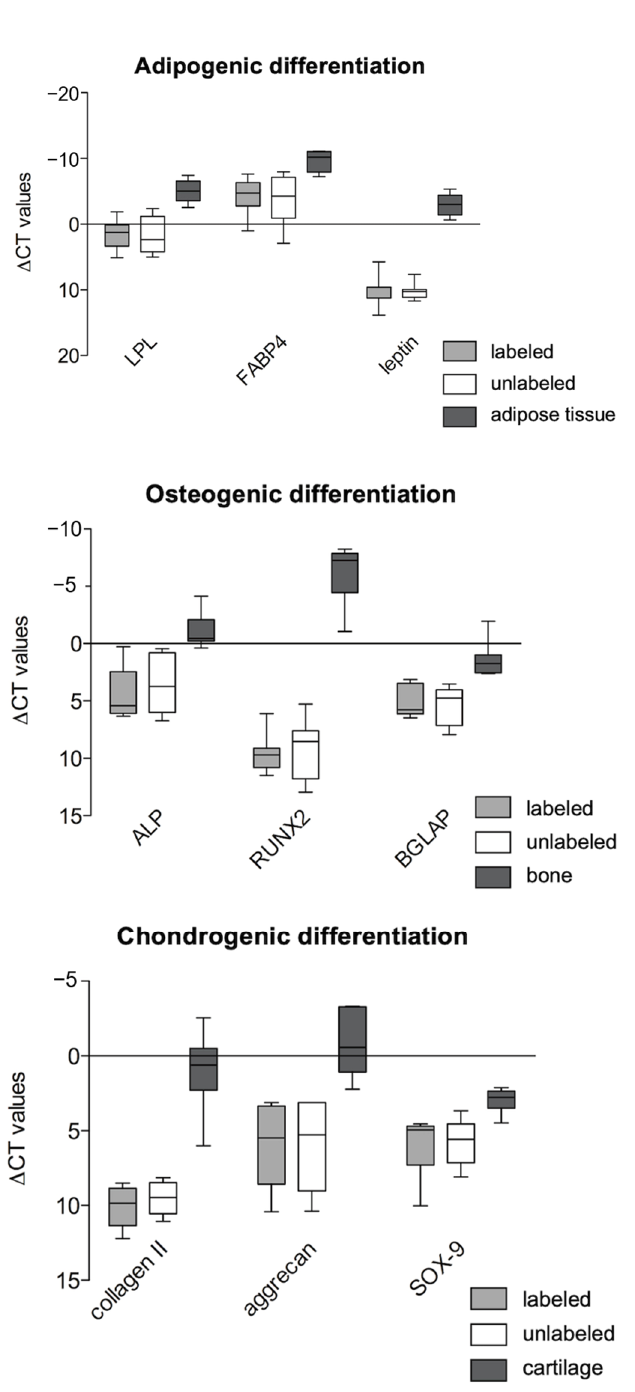
Figure 9. Real time-PCR analyses after adipogenic, osteogenic and chondrogenic differentiation: The presented values (∆CT values) are normalized to the gene expression values of GAPDH. No differences in the expression of specific marker genes after adipogenic, osteogenic and chondrogenic induction between labeled and unlabeled hASCs were detected. Native tissues such as adipose tissue, bone and cartilage were used as positive controls.